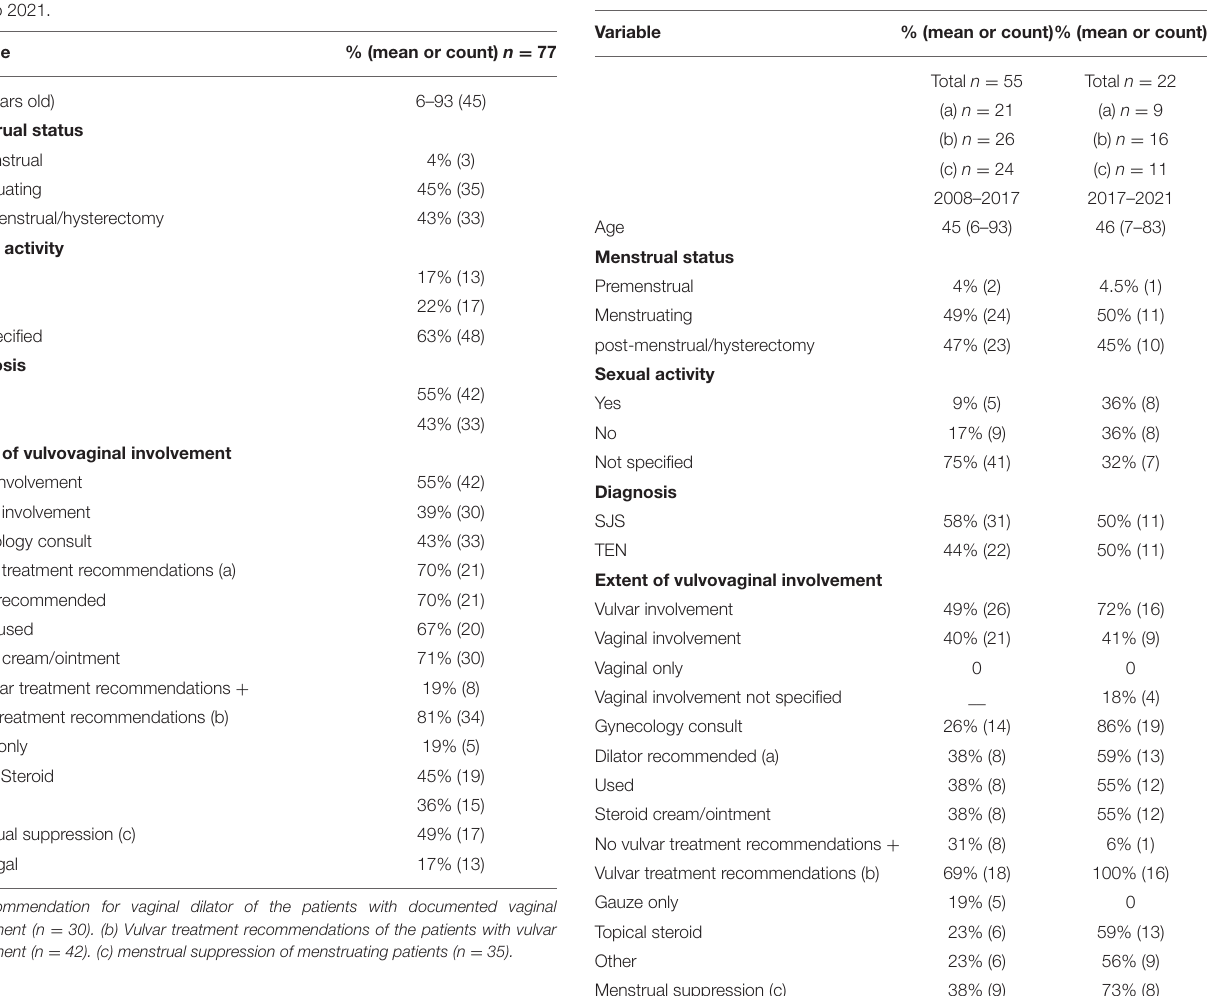
TABLE 2 | Demographics and clinical variables of patients with